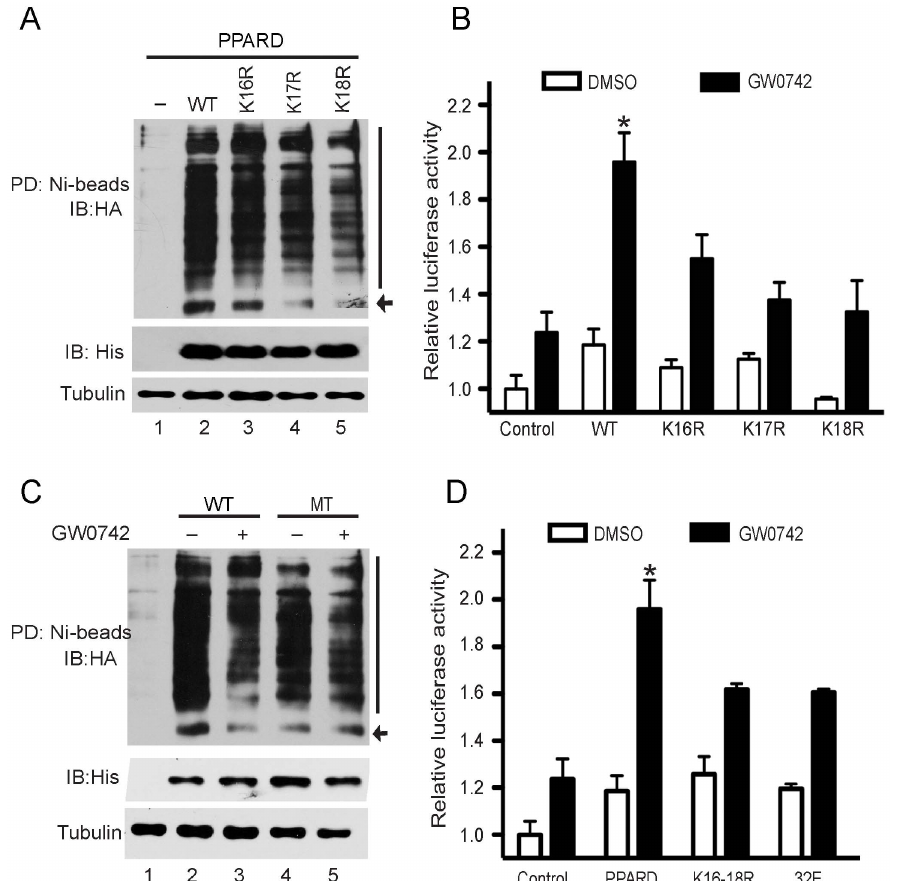
Figure 5. The G32E substitution attenuates ubiquitination of sPPARD and consequently reduces transcription activity of sPPARD. (A) Lysines 16, 17 and 18 are ubiquitination sites of sPPARD. HEK293T cells were transfected with pcDNA4A-His, -wild-type sPPARD (WT), -K16R, -K17R, or -K18R expression vectors along with HA-ub vector, and then after 24 hours cells were incubated with 10 m M PS341 for 4 h. His-tagged sPPARD was pulled down with nickel affinity gel under denaturing conditions. Expression levels of sPPARD and tubulin in cell lysates are shown below. An arrow and a bar indicate mono-ubiquitinated and poly-ubiquitinated sPPARD, respectively. (B) The ubiquitination in the A/B domain of sPPARD promotes its transcription activity. Luciferase activity of wild-type sPPARD (WT) and K16R, K17R, K18R mutants were assessed as described in the legend for Figure 1B. An asterisk indicates significant ( P , 0.05) difference between several forms of sPPARD. (C) The G32E substitution reduces ubiquitination of sPPARD. HEK293T cells expressing wild-type sPPARD or G32E mutant were incubated with ( + ) or without (-) GW0742 overnight and analyzed as mentioned above. (D) Both G32E and K16-18R mutants reduce transcription activity of sPPARD. Luciferase activity of His-tagged sPPARD, -K16-18R and -G32E mutants (32E) were assessed as described in the legend for Figure 1B. An asterisk indicates significant ( P , 0.05) difference between several forms of sPPARD.